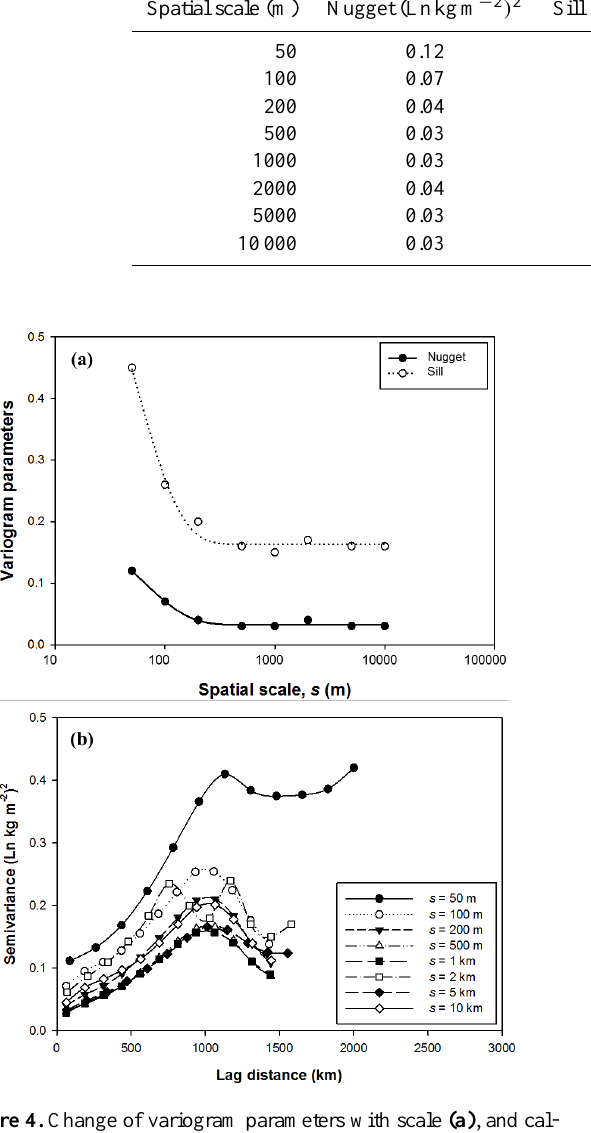
Figure 4. Change of variogram parameters with scale (a) , and cal- Figure 4: culated variograms of log-transformed predicted SOC stocks (b) at spatial scales of 50, 100, 200, and 500m and 1, 2, 5, and 10km. Fit- ted functions are sill = 0.163 + 0.763 × exp( − 0.0197 × s ), adjusted R 2 = 0.98, P <0.001; Nugget = 0.032 + 0.201 × exp( − 0.016 × s ), adjusted R 2 = 0.98), P